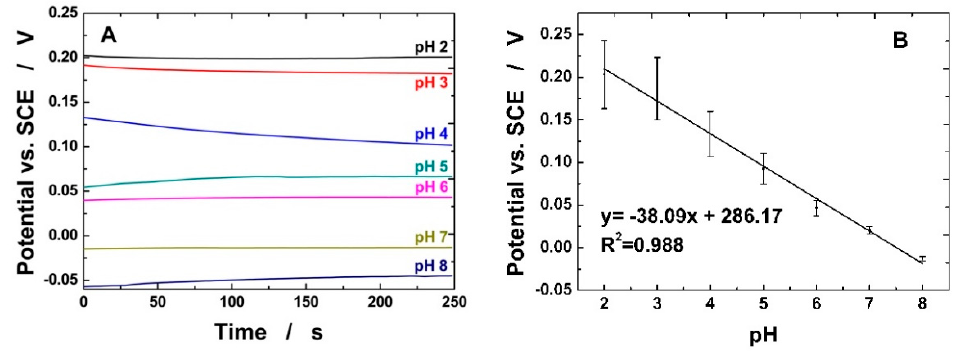
Figure 4. ( A ) OCP vs. time curves; ( B ) calibration line of PANI/ITO-PET electrode.